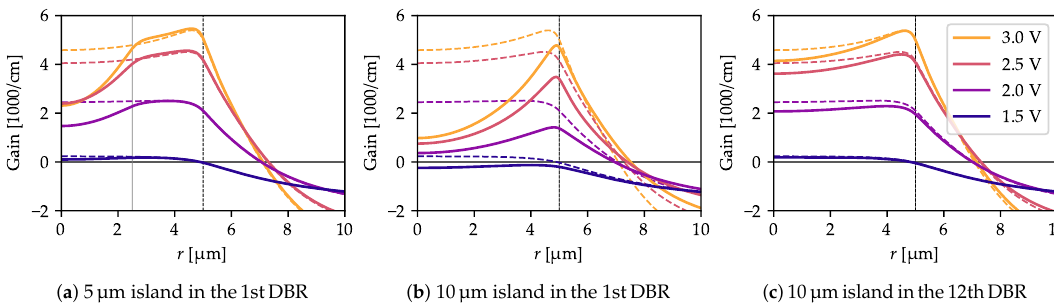
Figure 5. Gain distribution (with spatial hole burning effect neglected) in the active region for several contact-to-contact voltages in a structure with 5µm ( a ) and 10µm ( b , c ) oxide islands located in the 1st ( a , b ) and 12th DBR pair ( c ) compared to the structure with no oxide island at all (thin dashed lines in all plots). The presence of the island influences the gain distribution only if it is located very close to the